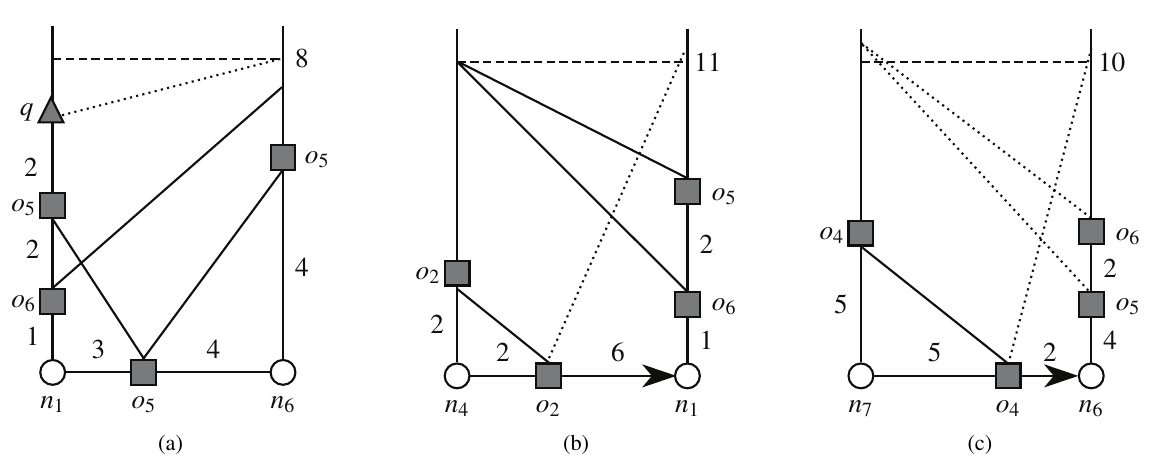
−−→ −−→ n 4 n 1 (c) n 7 n